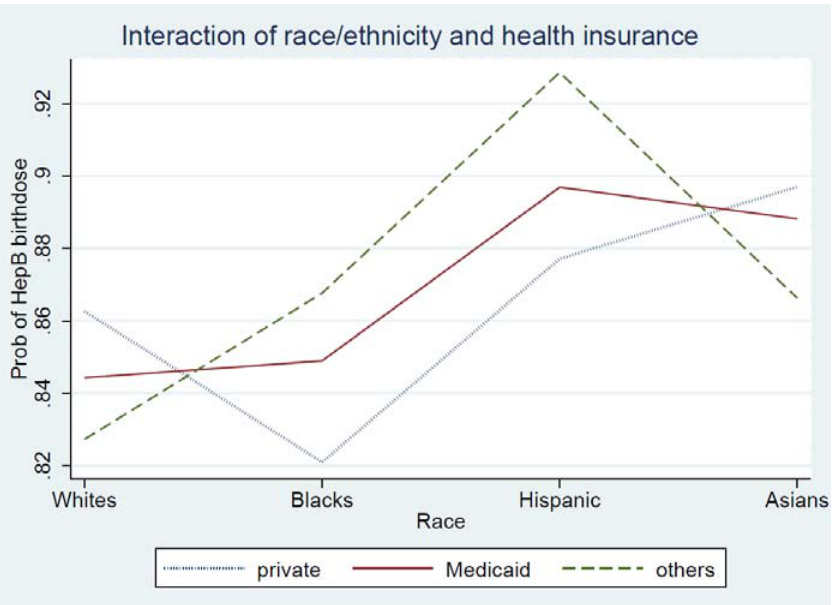
Figure 2. Interaction of race/ethnicity and health insurance type on HepB birth dose. Note p < 0.001.